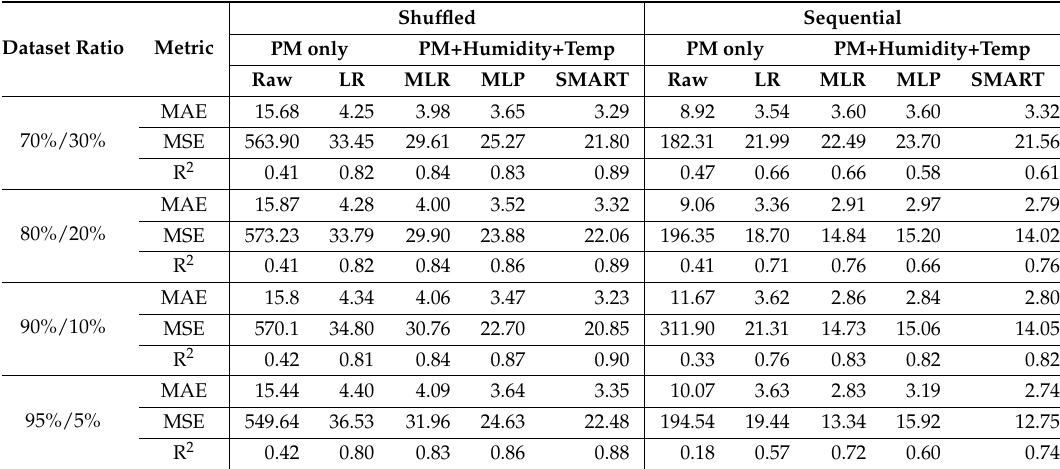
Table 7. Metric analysis for data preprocessing methods (shuffled/sequential—5 min sampling interval condition).